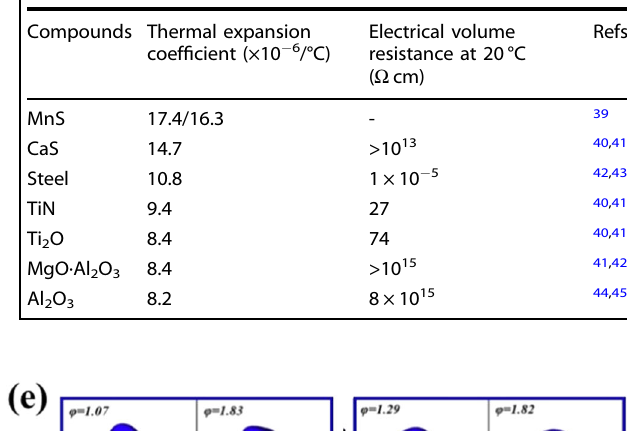
Table 1. Physical properties of typical components used in this work 39 – 45 .